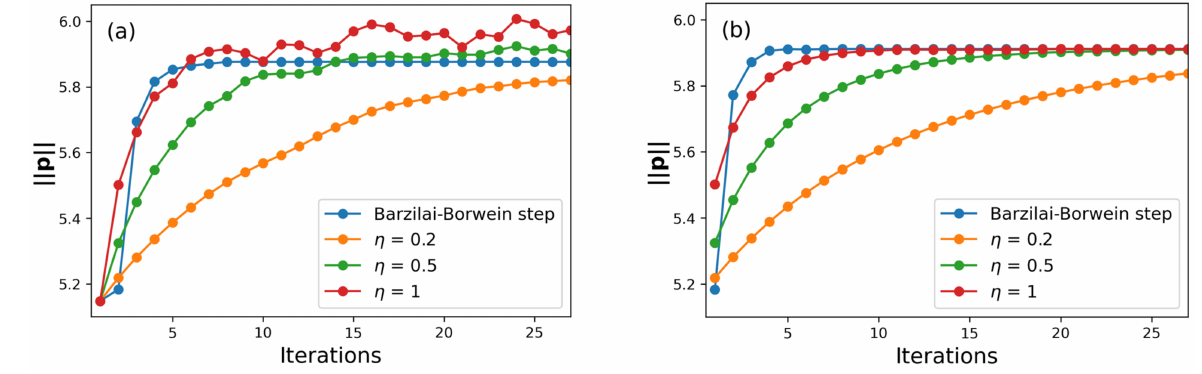
Figure 3. Convergence of the iterative optimization method. ( a ) Mesh 1; ( b ) Mesh 4. The convergence rate becomes slower when vertically differentiated products were introduced. A comparison of the convergence rate with the iterative steps, considering different values for quality of the product for some of the firms, is shown in Figure 4. Bigger differences of quality led to a lower rate of